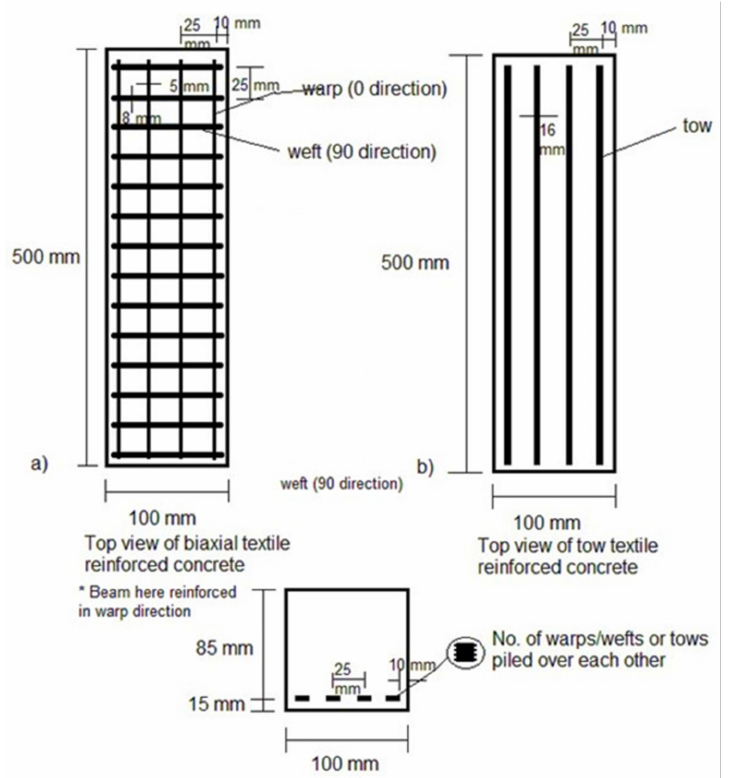
Figure 3. The details of textile reinforcement in ( a ) bi-axial TRC, ( b ) tow TRC small-scale beams.